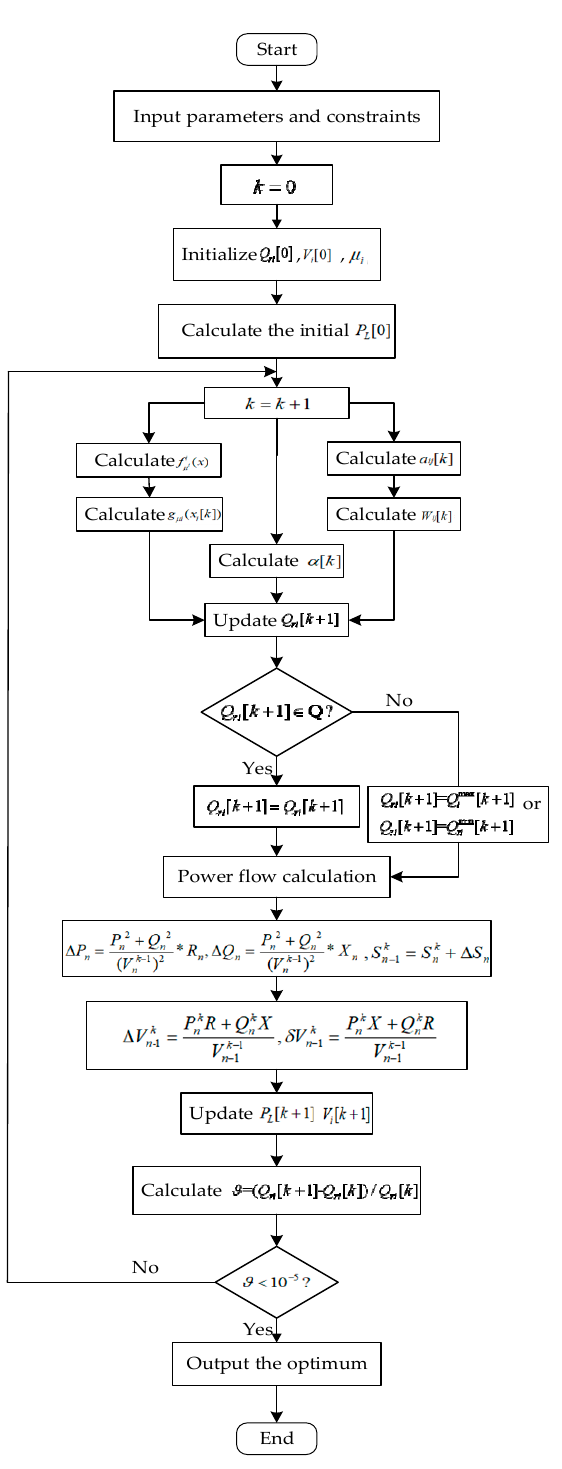
Figure 2. The flowchart for reactive power optimization for distribution network via the distributed random gradient free algorithm.